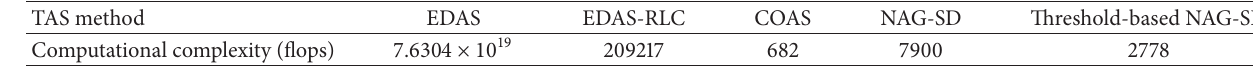
Table 1: Computational complexity comparisons.